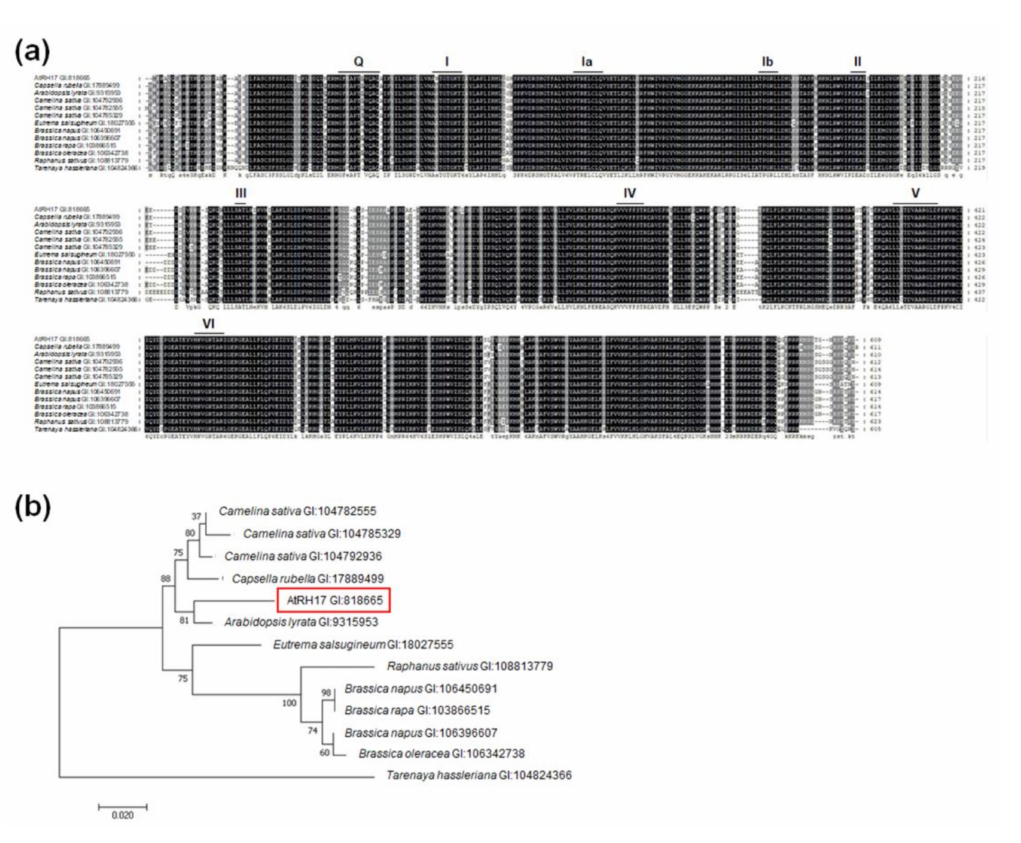
Figure 2. Conservation of DEAD-box RNA helicase (RH) motifs between AtRH17 and its 12 orthologs. ( a ) Multiple sequence alignment was carried out with amino acid sequences of the entire open reading frames (ORFs) of AtRH17 and the 12 orthologs using ClustalX 2.1 program. The gene ID number of each protein sequence is as follows: AtRH17: 818665; Capsella rubella : 17889499; Arabidopsis lyrata : 9315953; Camelina sativa : 104792936, 104782555, 104785329; Eutrema salsugineum : 18027555; Brassica napus : 106450691, 106396607; Brassica rapa : 103866515; Brassica oleracea : 106342738; Raphanus sativus : 108813779; Tarenaya hassleriana : 104824366. ( b ) Molecular phylogenetic tree of AtRH17 and the 12 orthologs was generated with the conserved regions including the well-conserved nine motifs (48–442 aa in AtRH17) using Maximum Likelihood method in MEGA 7.0.26 software. The number on each node indicates the bootstrap value for 1000